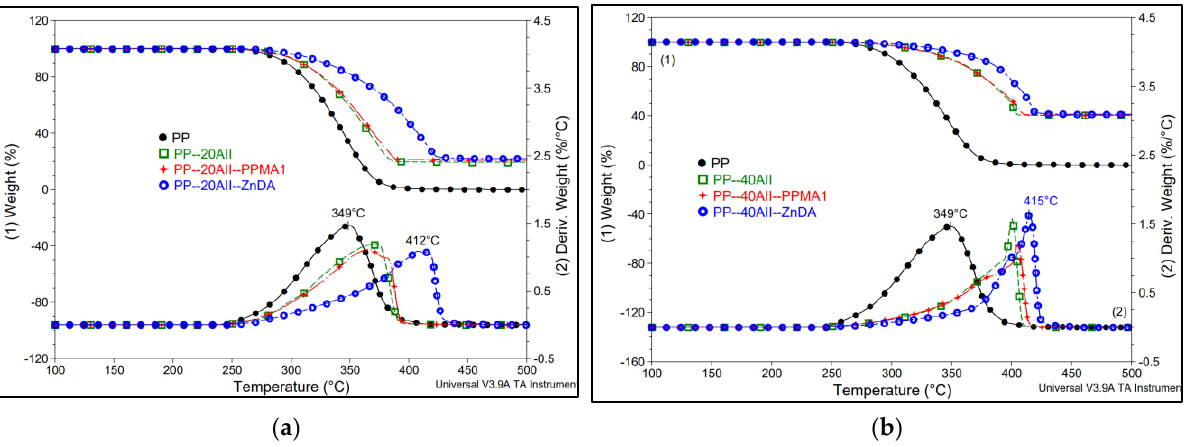
Figure 5. ( a , b ) Comparative TG and D-TG curves of PP and PP – AII composites filled with different amounts of filler: ( a ) 20% AII and ( b ) 40% AII (TGA under air, 20 °C/min).